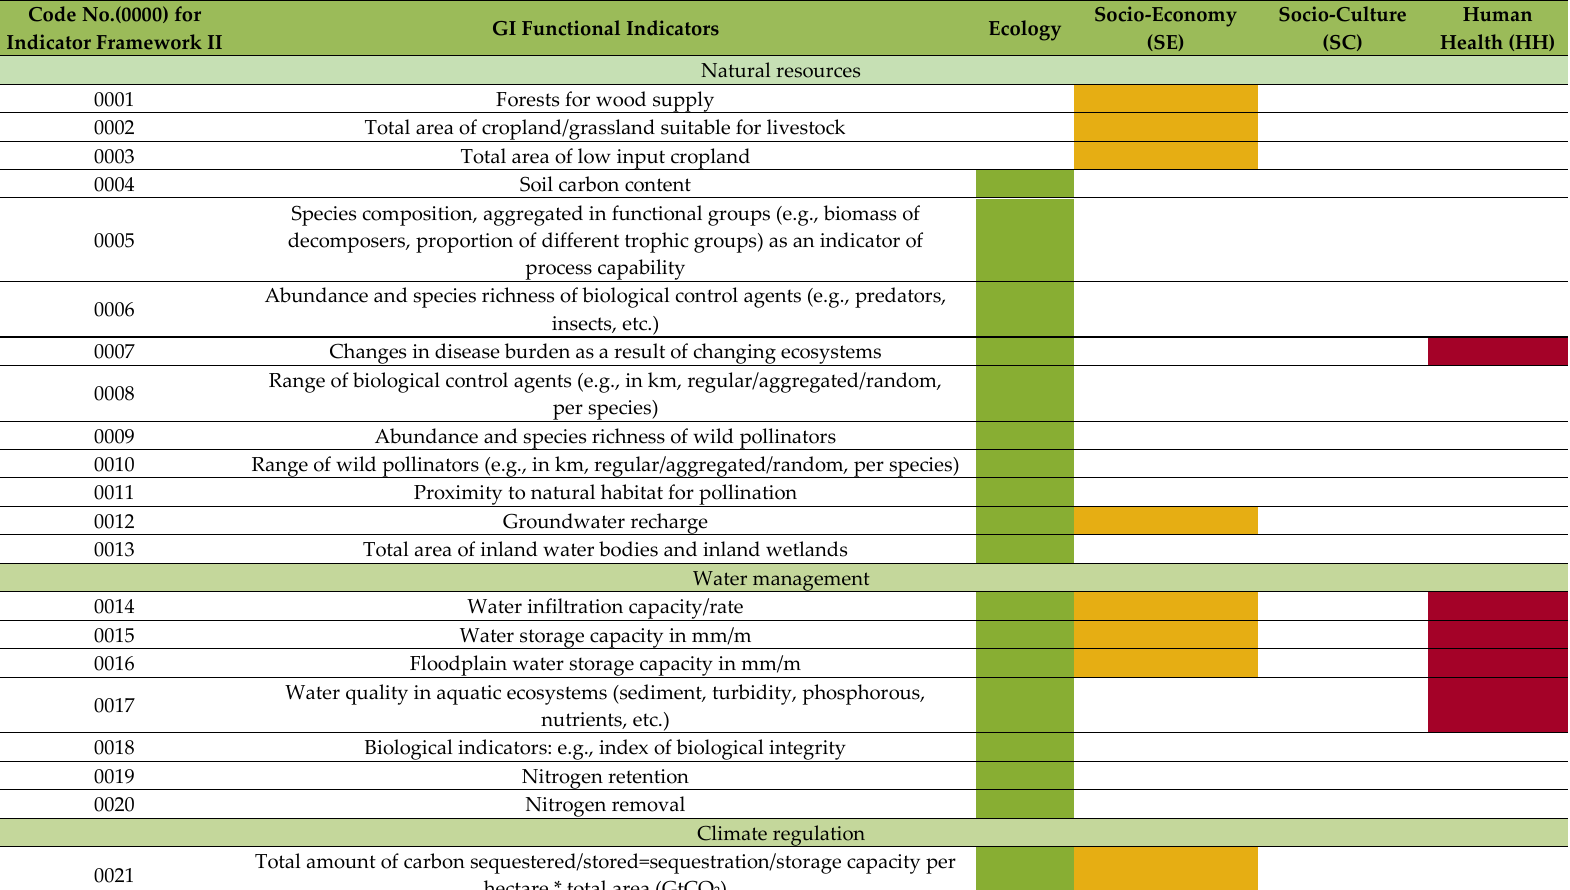
Table A2. Indicator framework II for GI implementation from IEEP and classified in terms of four dimensions, i.e., ecological dimension (green color), socio-economic dimension (yellow color), socio-cultural dimension (purple color), and human health (red color) dimension. Code No.(0000)